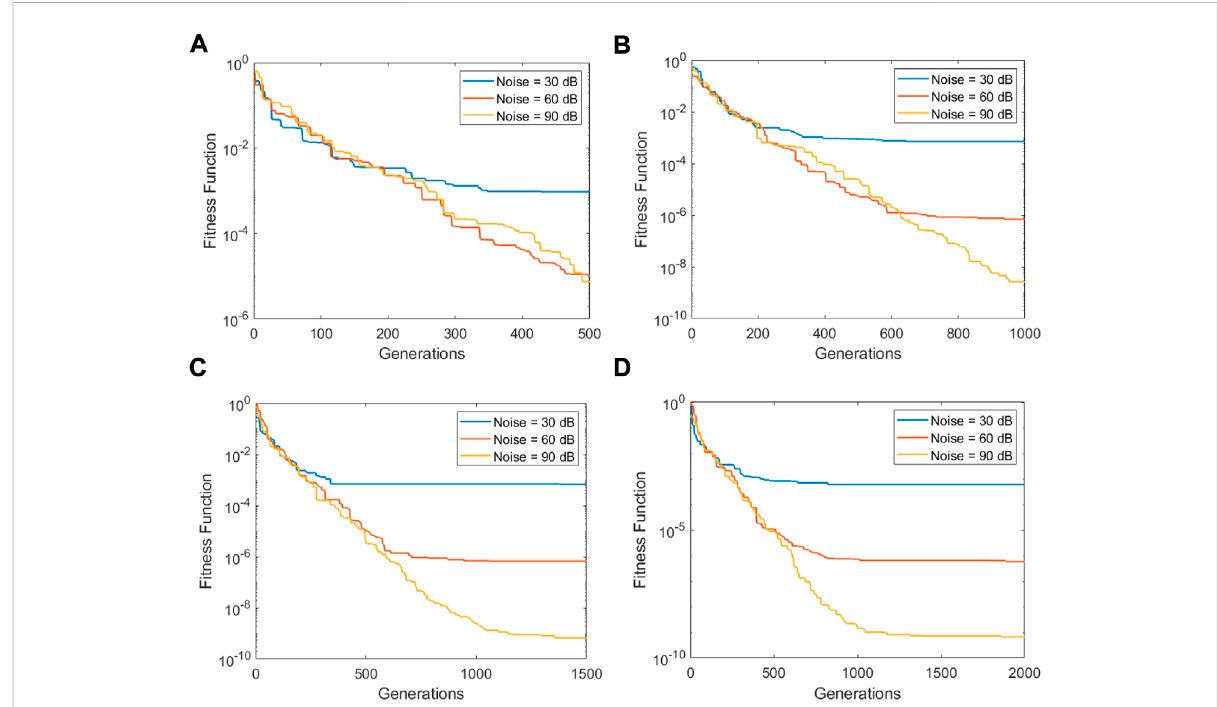
FIGURE 2 Convergence plots of Example 1: (A) G = 500, (B) G = 500, (C) G = 500, and (D) G = 500.